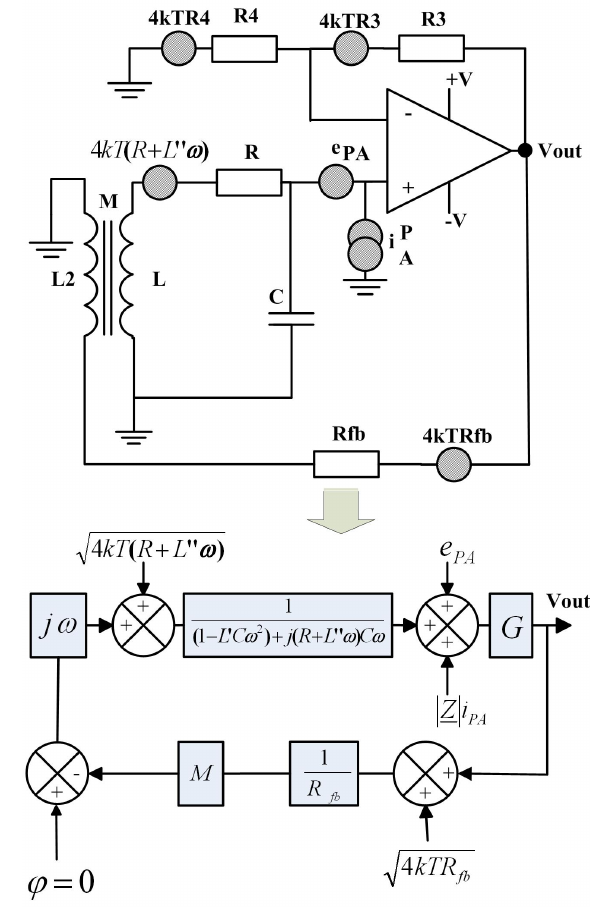
Figure 8. Noise sources in the feedback flux induction configura- tion and block diagram representation.